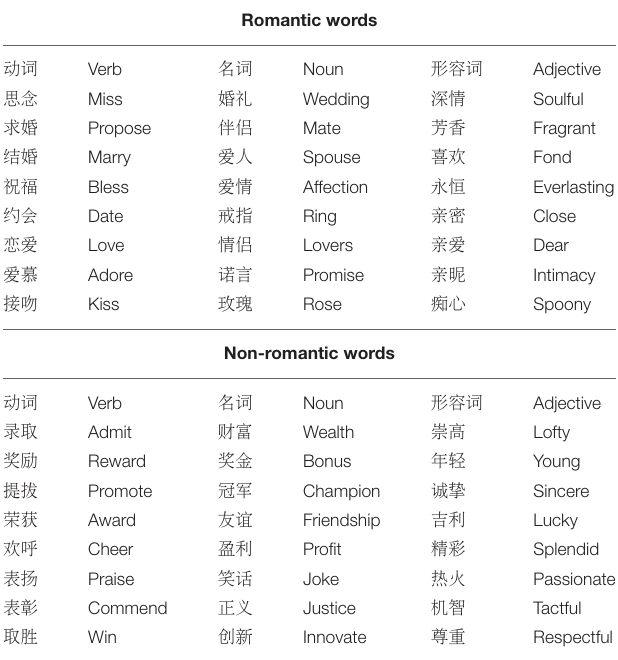
TABLE A1 | Romantic and non-romantic words used in the